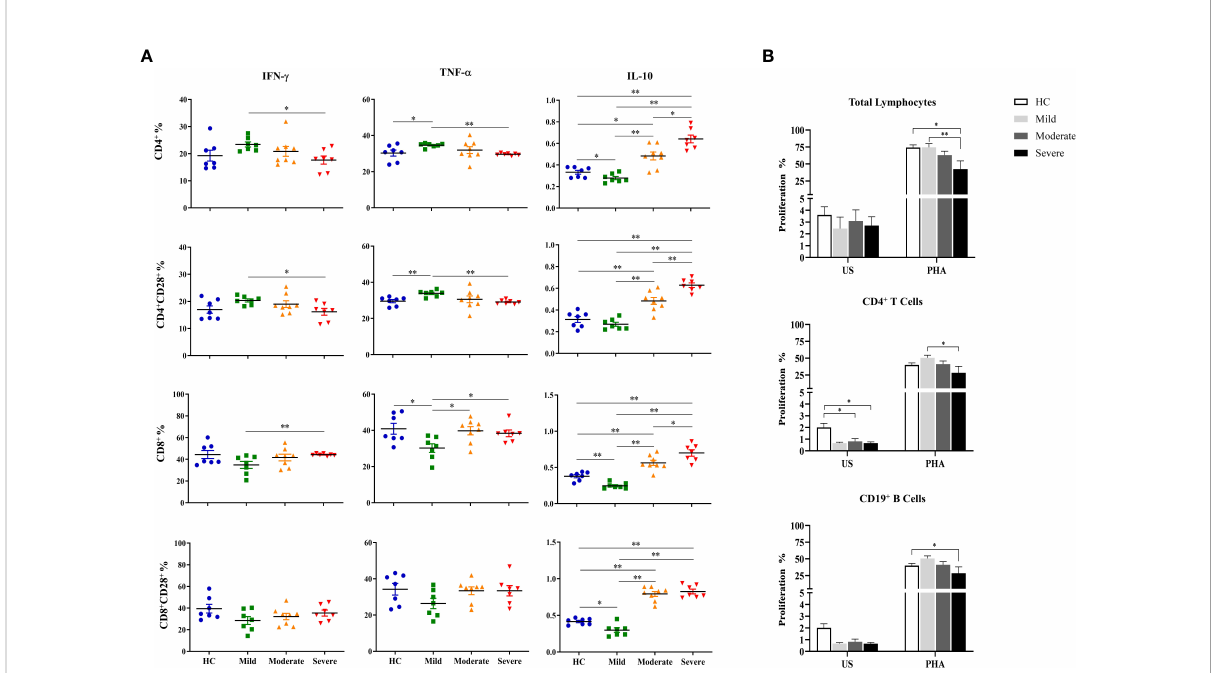
FIGURE 4 Determination of intracellular cytokine levels in CD4 + and CD8 + T cells and the proliferative capacities of lymphocytes. (A) IFN- g , TNF- a and IL- 10 levels of CD4 + , CD4 + CD28 + , CD8 + and CD8 + CD28 + T cells. (B) The proliferative capacity of total lymphocytes. T and B cells were shown in patient groups and healthy controls. *p<0.05, **p<0.001, HC, Healthy